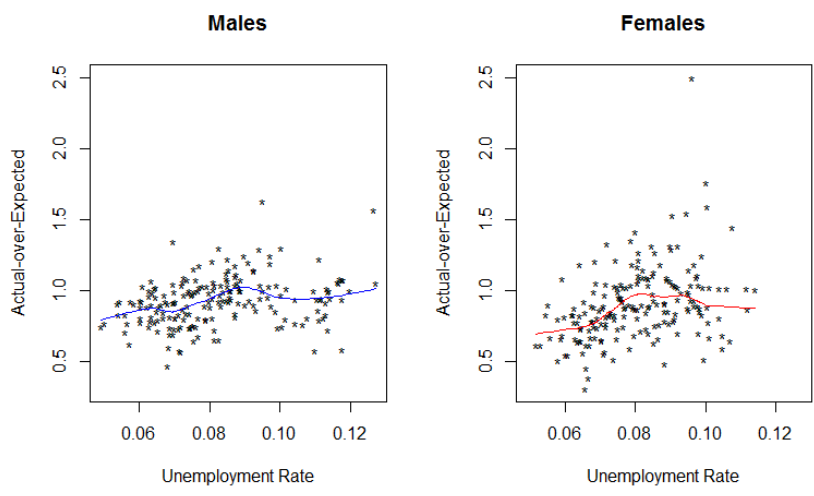
Figure 2. Insured population: Scatterplot of A/E vs unemployment